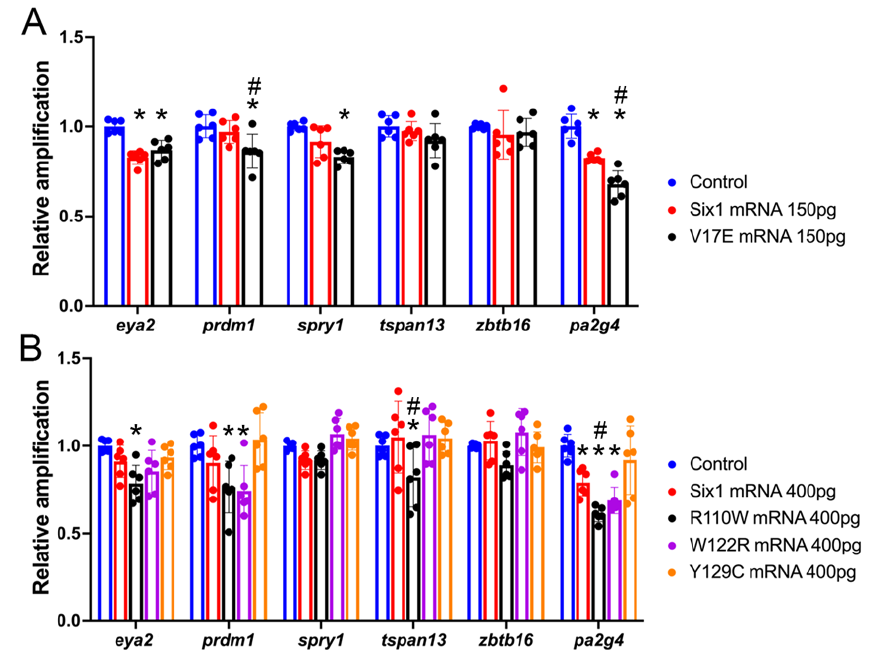
Figure 3. Gene expression changes in whole head samples assessed by qPCR. ( A ). Levels of expression in whole heads collected from uninjected, sibling-matched embryos (controls, blue bars), and embryos injected with mRNA encoding either Six1WT (red bars) or V17E (black bars). Significant differences from control ( p < 0.05) are indicated by an asterisk; significant differences from Six1WT ( p < 0.05) are indicated by #. ( B ). Levels of expression in whole heads collected from uninjected, sibling-matched embryos (controls, blue bars), and embryos injected with mRNA encoding either Six1WT (red bars), R110W (black bars), W122R (purple bars) or Y129C (orange bars). Significant differences from control ( p < 0.05) are indicated by an asterisk. Significant differences from Six1WT ( p < 0.05) are indicated by #. Data are from three independent samples run in duplicate.